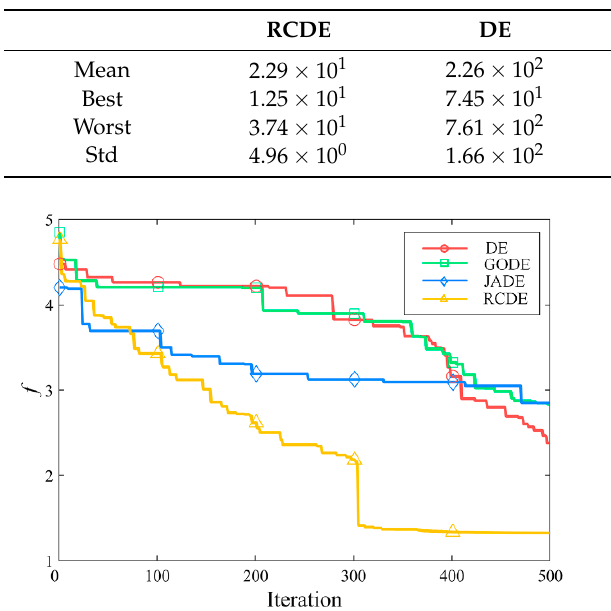
Table 8. Performance of four algorithms for solving Case 3.